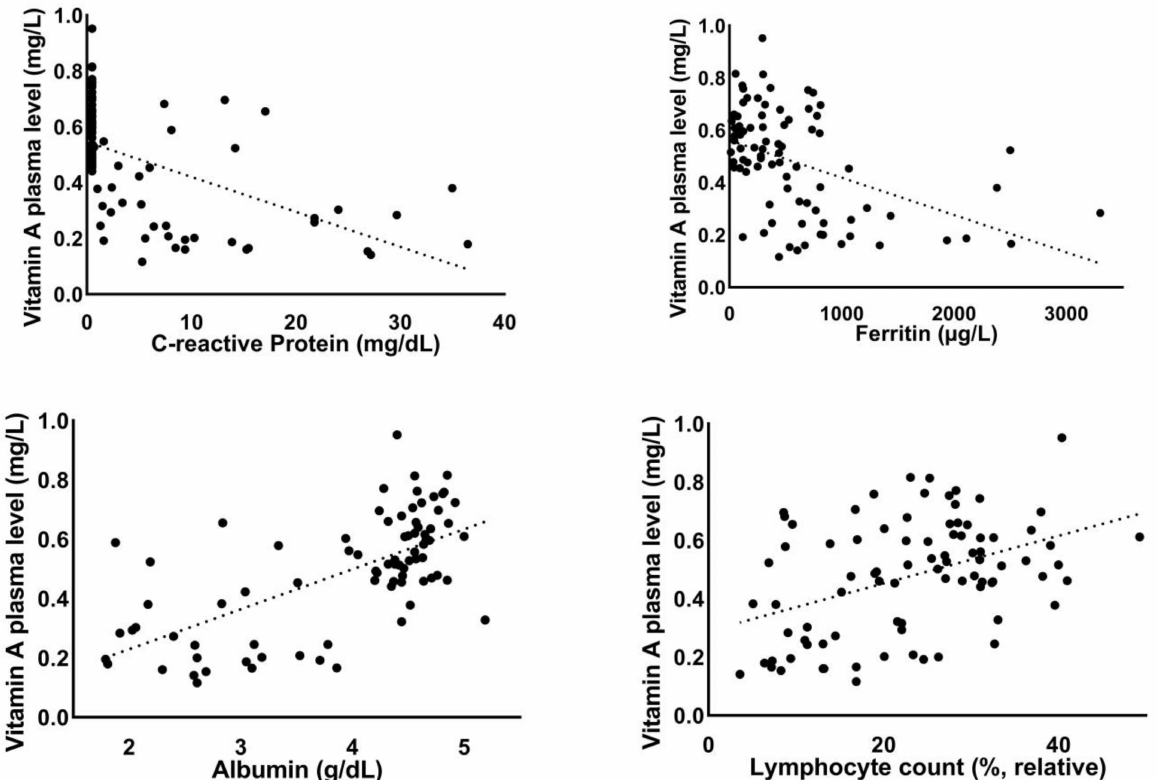
Figure 1. Correlation of vitamin A plasma levels with laboratory parameters.